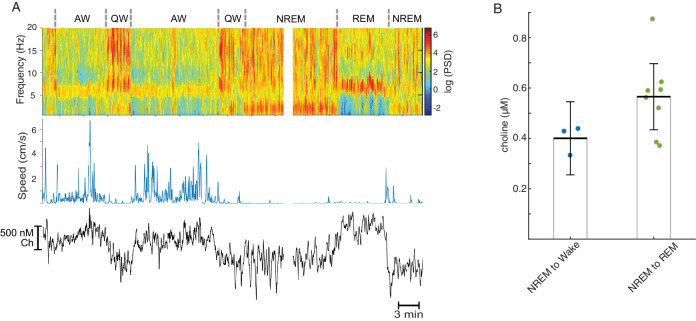
Tonic COA dynamics across brain states in a freely moving animal.(A) Representative recording across multiple brain states showing power spectrogram from a silicon probe site at hippocampal fissure (top), rat speed (middle) and clean ChOx signal (bottom). (B) Change in tonic putative Ch levels following transitions from NREM sleep to wake (n = 3) or REM sleep (n = 9). Both groups were significantly different from zero (p=0.046 for NREM to Wake and p<0.0001 for NREM to REM, inferred from one-way anova followed by Tukey-Kramer post-hoc analysis). An outlier was excluded from the NREM to REM group (1.64, exceeding three median absolute deviations away from median).